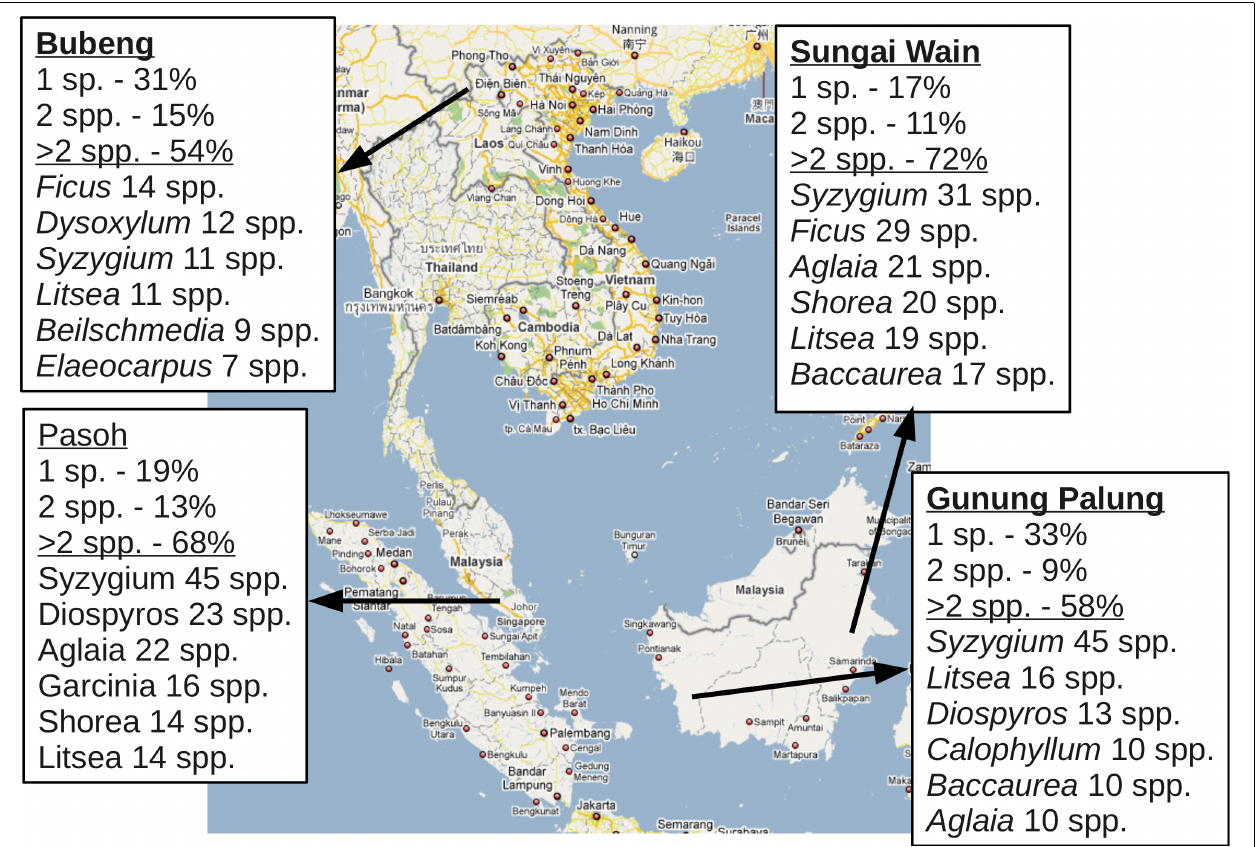
FIGURE 1 | Percentage of species existing in sympatry with congenerics and species richness of most diverse tree genera in four locations across tropical Asia. “1 sp.” illustrates the number of species with a only one species from a genus present in the community; “2 spp.” illustrates the number